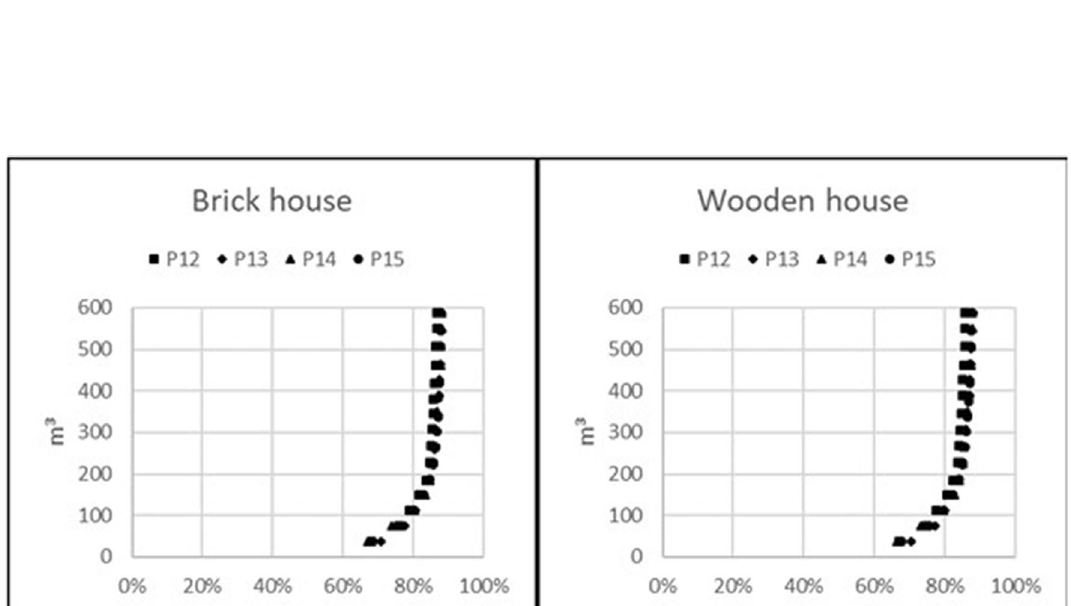
Figure 3. Volume of generated waste caused by topsoil removal with regard to relative dose reduction for observation points outside a brick or a wooden house on properties